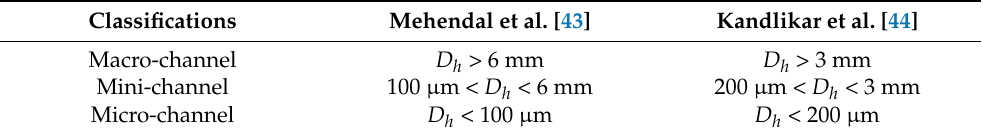
Table 2. Classifications of flow channels based on D h .